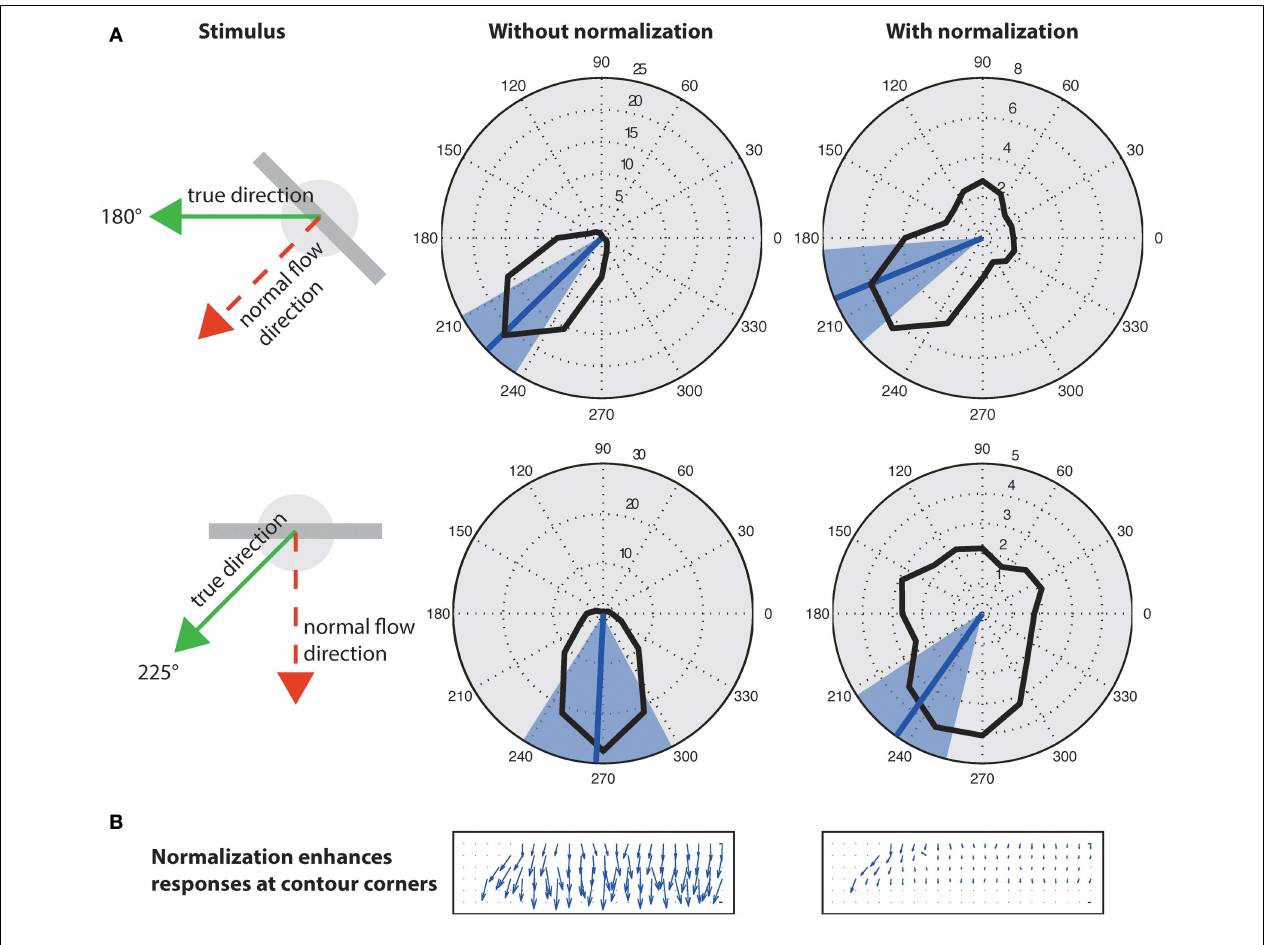
estimate toward the true motion direction. The circles on the elongated bar stimulus show the size of kernel weighting functions. (B) Normalization suppresses responses “within” the line and enhances responses at its endings (line ends, corners) that encode the true motion direction (c.f. Guo et al., 2006; Tsui et al.,